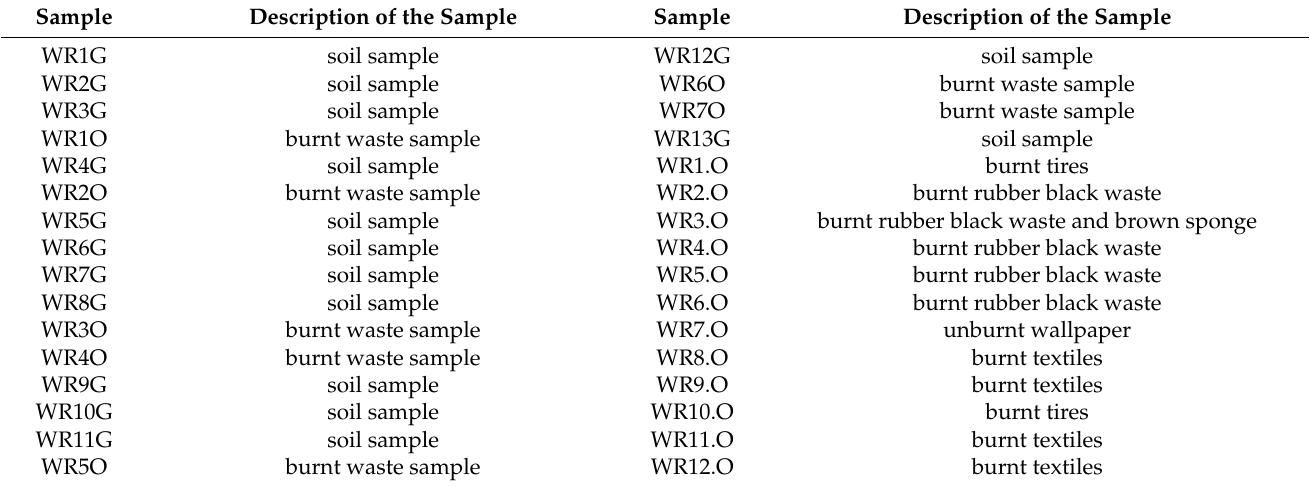
Table 1. Sample code and